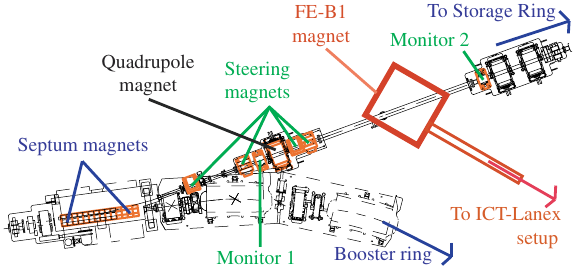
FIG. 1. Schematic of a part of the booster synchrotron and a part of the booster-to-storage beam line of the Advanced Light Source. The first pair of the steering magnets (horizontal and vertical) was used to align e-beams on monitor 1, and second pair for monitor 2 in the same manner. Shown by the square is the location of the FE-B1 magnet that was used to send e-beams to the experimental setup shown in Fig. 2. The location of the last quadrupole magnet for this experiment is indicated as